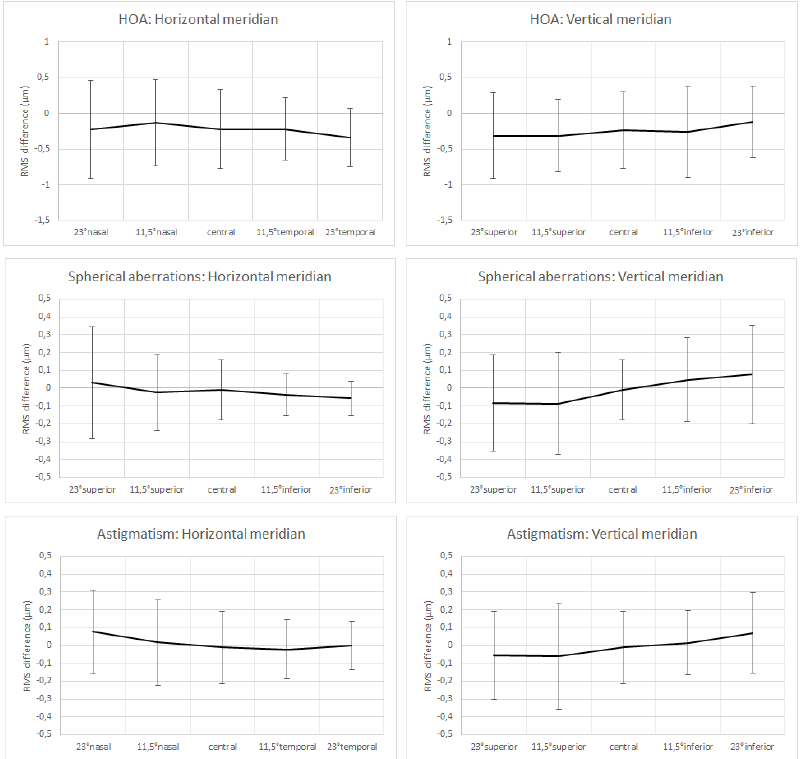
Figure 3. Difference of total HOA, higher order astigmatism and spherical aberrations between relaxed and accommodated states in the central and peripheral retina. Error bars show the standard deviation of each mean value. RMS: root-mean-square, HOA: higher order aberration. Table 2. Mean difference of the higher order Zernike coefficients (μm) between non-accommodated and accommodated status in central and peripheral retina a .